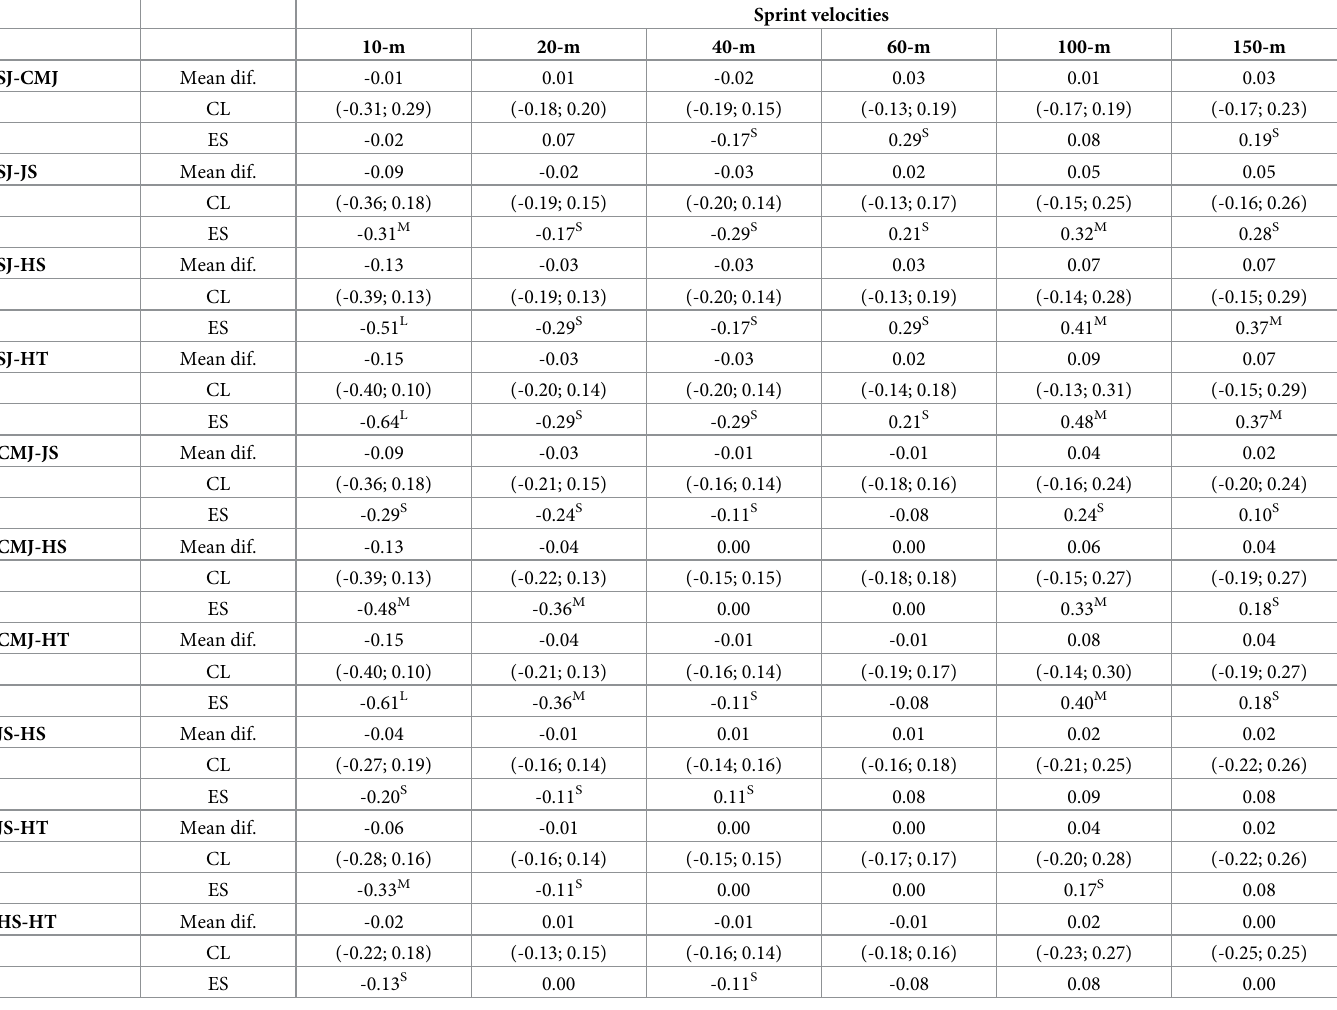
Table 3. Mean differences (± 95% confidence limits; CL) and effect sizes (ES) for the comparisons between significant correlations.